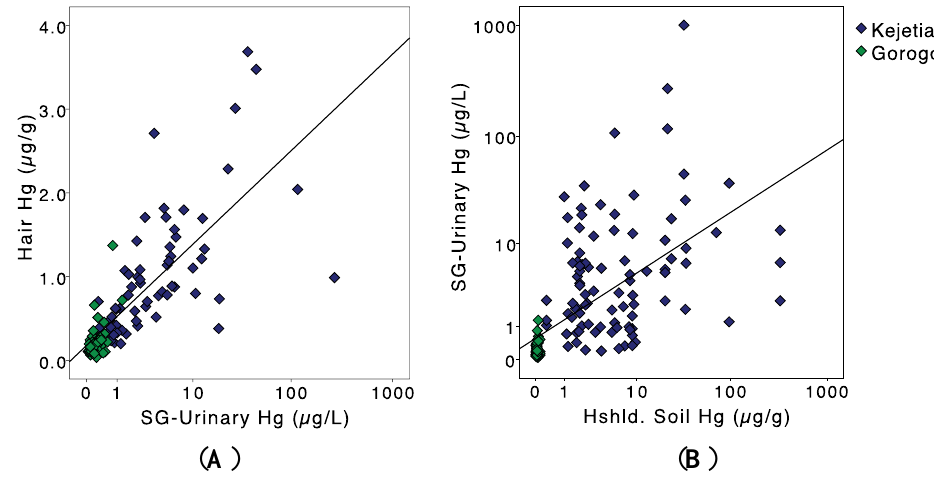
Figure 3. ( A ) Personal specific gravity (SG) adjusted urinary Hg (log-scale axis) by hair Hg concentrations; R 2 = 0.592; and ( B ) household soil Hg by personal specific gravity (SG) adjusted urinary Hg concentrations (log-scale axes); R 2 = 0.373.